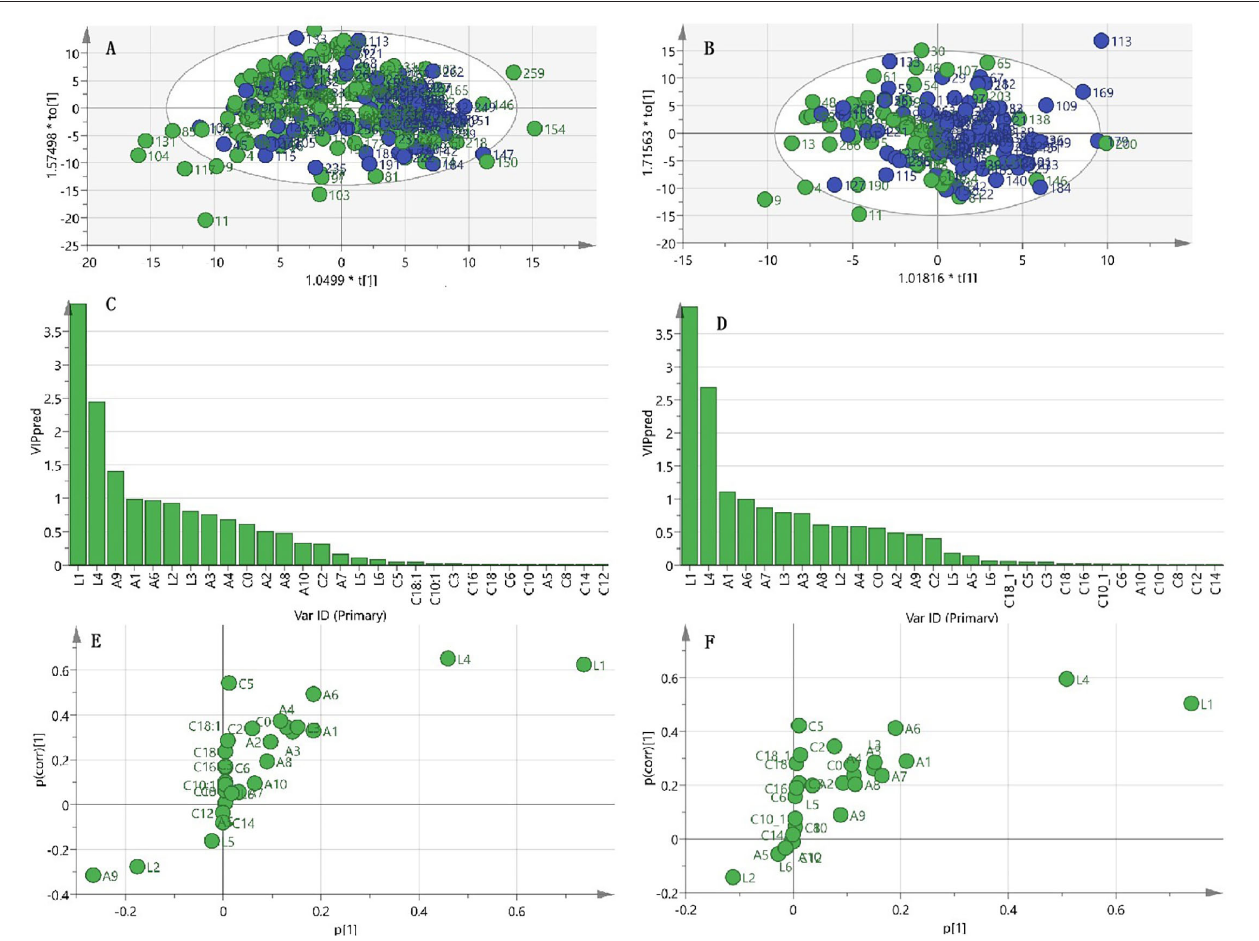
FIGURE 2 | OPLS-DA analysis for frailty status using metabolism data. (A) Scatter plot of OPLS-DA model analysis for frailty (green circle) vs. non-frailty groups (blue circle) by the main components. (B) Scatter plot of OPLS-DA model analysis for frailty and sarcopenia (F&S) (green circle) vs. non-frail and non-sarcopenic control (blue circle) by the main components. (C) Ordered list of metabolites with higher discrimination ability based on variable importance for the projection (VIP) score for separation of frailty and non-frailty groups. (D) Ordered list of metabolites with higher discrimination ability based on VIP for separation of frailty and sarcopenia (F&S) vs. non-frail and non-sarcopenic control. (E) S-plot of the OPLS-DA model of the frailty and non-frailty groups. (F) S-plot of the OPLS-DA model of frailty and sarcopenia vs. the non-frail and non-sarcopenic control. A9, glycine; A1, valine; A6, tryptophan; A3, leucine; A4, tyrosine; A2, Ileucine; A8, glutamate; A10, alanine; A7, glutamine; A5, phenylalanine; C0, carnitine; C2, acetylcarnitine; C3, propionyl-L-carnitine; C5, valeryl-L-carnitine; C6, AcyCNhexenoyl-L-carnitine; C8, octanoyl-L-carnitine; C10, decanoyl-L-carnitin; C10:1, decenoyl-L-carnitine; C12, dodecanoy-L-carnitine; C14, tetradecanoyl-L-car-nitine; C16, hexadec-C16anoyl-L-carnitine; C18, octadecanoyl-L-carnitine; C18:1, octadecenoyl-L-carnitine; L1, 1-palmitoyl-2-hydroxy-sn-glycero-3-phosphocholine (LPC16:0); L2, 1-stearoyl-2-hydroxy-sn-glycero-3-phosphocholine (LPC18:0); L3, 1-oleoyl-2-hydroxy-sn-glycero-3-phosphocholine (LPC18:1); L4, 1-linoleoyl-2-hydroxy-sn-glycero-3-phosphocholine (LPC18:2); L5, trimethylamine-N-oxide (TMAO); L6,